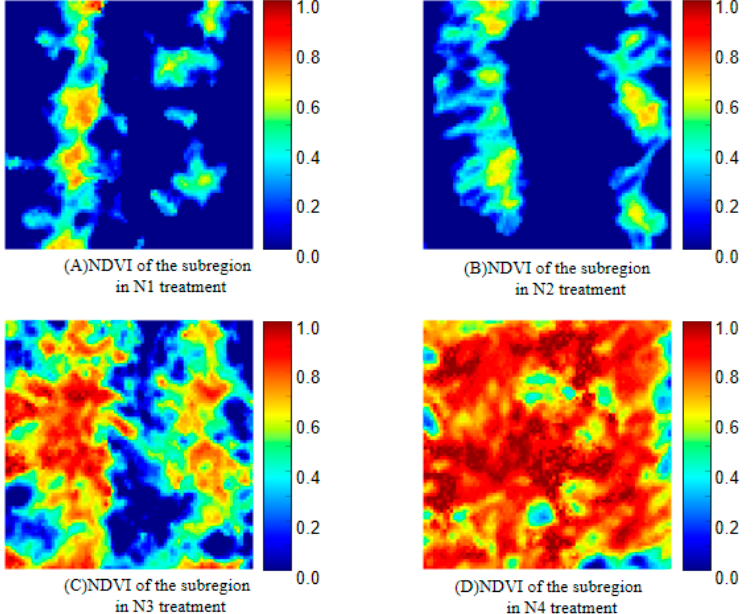
Figure 7. Photographs of different winter wheat tiller states: ( A ) N1, ( B ) N2, ( C ) N3 and ( D ) N4. Images obtained by UAV were cut into regions of 50 cm × 50 cm (Figure 8A). The Otsu algorithm was used to extract wheat seedling area and calculate the vegetation index of that wheat seedling area (Figure 8B). According to the vegetation index, wheat seedling area was divided into four types: NDVI minimum Region A, sub-small Region B, large Region C, and largest Region D. The mean values (VmA, VmB, VmC, VmD) and areas (VaA, VaB, VaC, VaD) of the four regions were respectively calculated. The coefficient of variation of the vegetation index (CVI) was calculated to obtain the gradient characteristics. The classification criteria are shown in Figure 8C, and the classification effect is shown in Figure 8D.